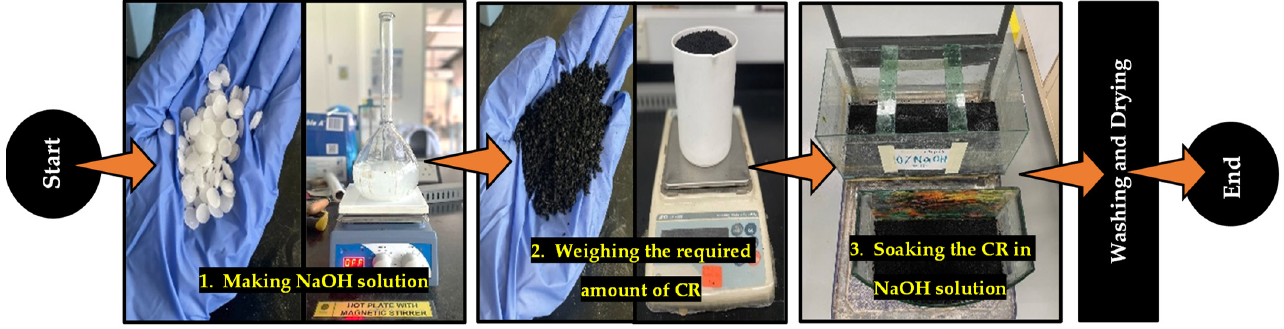
Figure 2. CR pretreatment process.